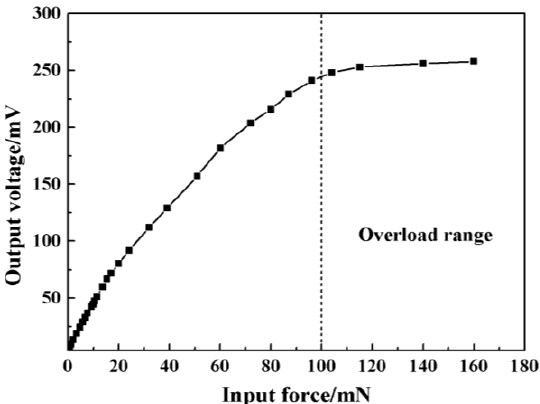
Figure 13. The results of overload protection.